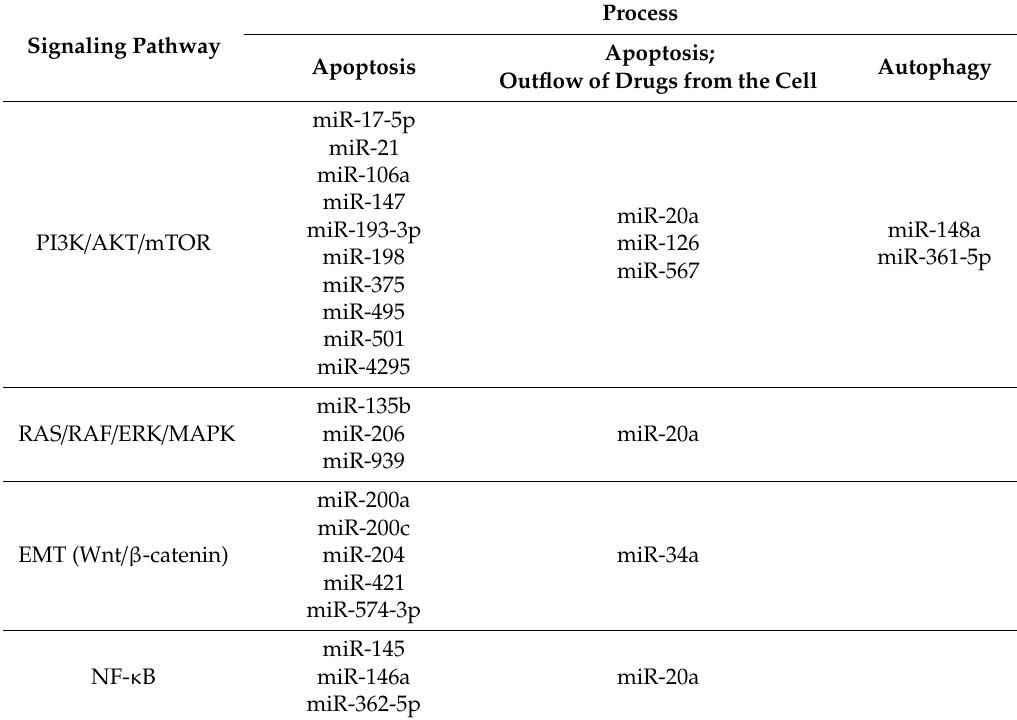
Table 2. The microRNAs and processes associated with GC